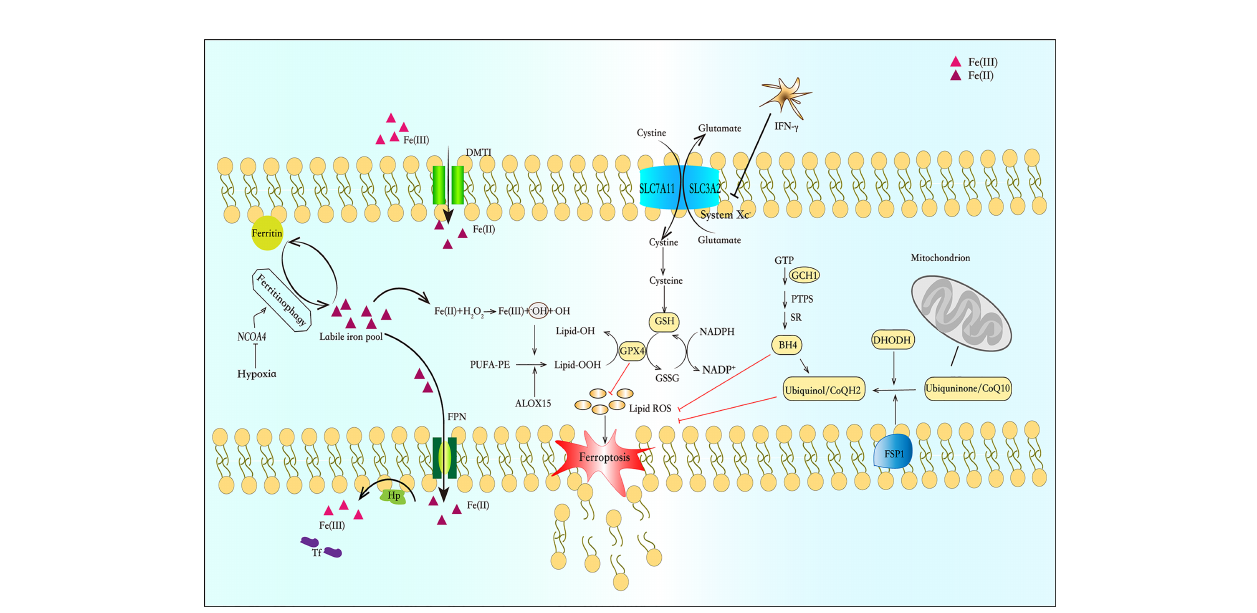
FIGURE 1 | Iron metabolism and the pathway of ferroptosis. Ferrireductase (DMT1) converts Fe (III) to Fe (II). Some of Fe (II) is bound to ferritin and forms cytosolic labile iron pool (cLIP), and some crosses the basolateral membrane through ferroportin (FPN) into the plasma to combine with transferrin (TF). Fe (II) can initiate liposome peroxidation through the Fenton reaction. The system x − c is a counter-transport that can ingest cystine and excrete glutamic acid to synthesize glutathione (GSH). Glutathione peroxidase 4 (GPX4) is a selenium enzyme that catalyzes GSH into oxidized glutathione (GSSG) and reduces toxic peroxides to non-toxic hydroxyl compounds. And the FSP1-CoQ-NADPH pathway and DHODH can inhibit lipid peroxidation and protect cells from ferroptosis by generating ubiquinol. In the GCH-BH4 pathway, GCH1 resists ferroptosis through its metabolite BH4. BH4 acts as a free-radical-trapping antioxidant or participates in ubiquinone synthesis to inhibit lipid